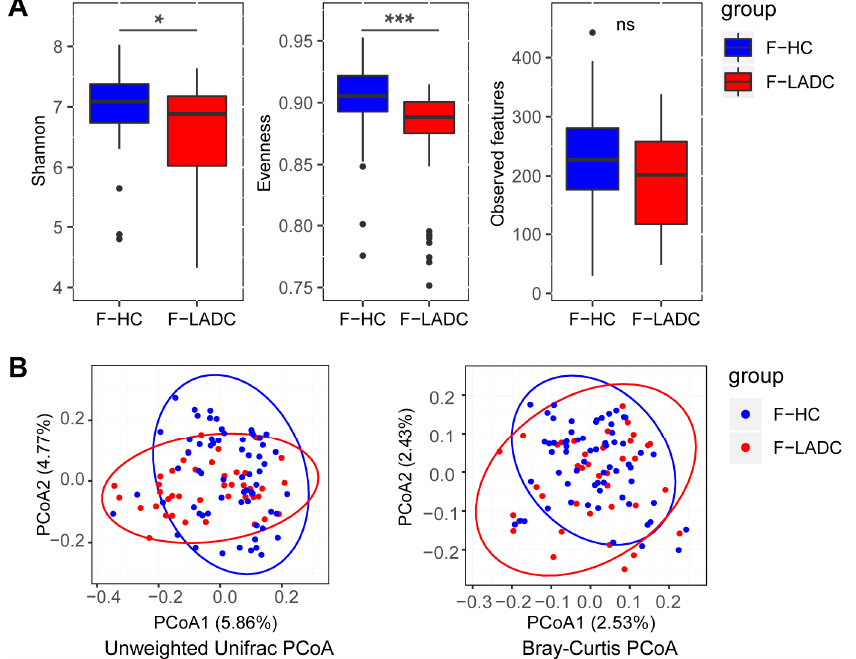
Figure 1. Gut microbiota dysbiosis in patients with LADC. ( A ) Differences in α -diversity between gut samples in LADC group (F-LADC) and healthy control group (F-HC) based on Shannon in- dexes, Evenness indexes, and Observed features. ***, p < 0.001; *, p < 0.05; ns, not significant. ( B ) β -Diversity differences between the LADC (red dots) and HC (blue dots) groups were estimated by principal coordinates analysis (PCoA). Left, unweighted UniFrac PCoA; right, Bray–Curtis PCoA. The percentage of variance explained by the first two principal coordinates is indicated in parentheses. Significant differences were observed between patients with LADC and healthy controls with an ANOSIM test (unweighted UniFrac, R = 0.1152, p = 0.001; Bray–Curtis, R = 0.1104, p = 0.002).